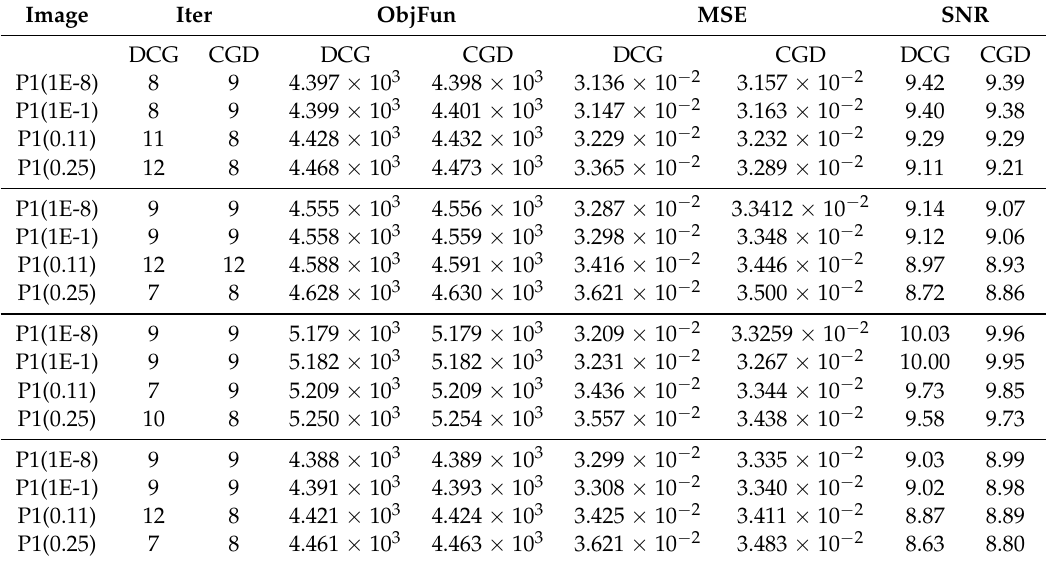
Table 10. Efficiency comparison based on the value of the number of iterations (Iter), objective